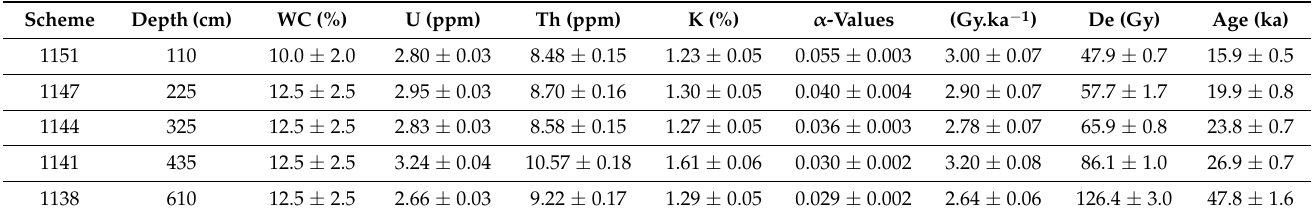
Table 2. Summary of sample codes, depth information, present-day water content (WC), radionuclide activities, α -values, total dose rates, weighted mean De values, and luminescence ages for the Novo Orahovo samples. Error terms are given at 1 standard